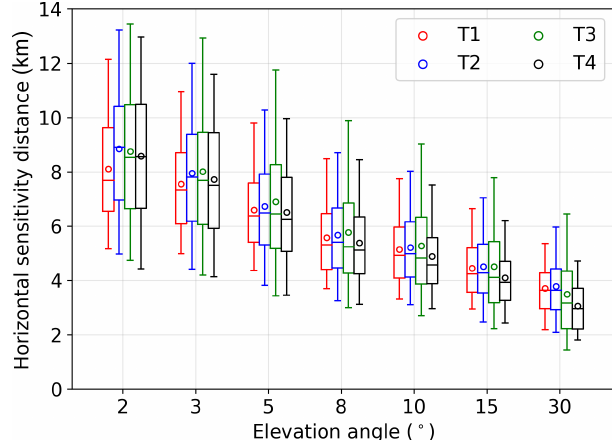
Figure C3. Typical horizontal sensitivity distances (HSD) for dif- ferent elevation angles along the viewing direction of the four tele- scopes. The HSD for an elevation angle α is estimated as the dis- tance along the viewing direction which accounts for 90% of sim- ulated dSCD α .